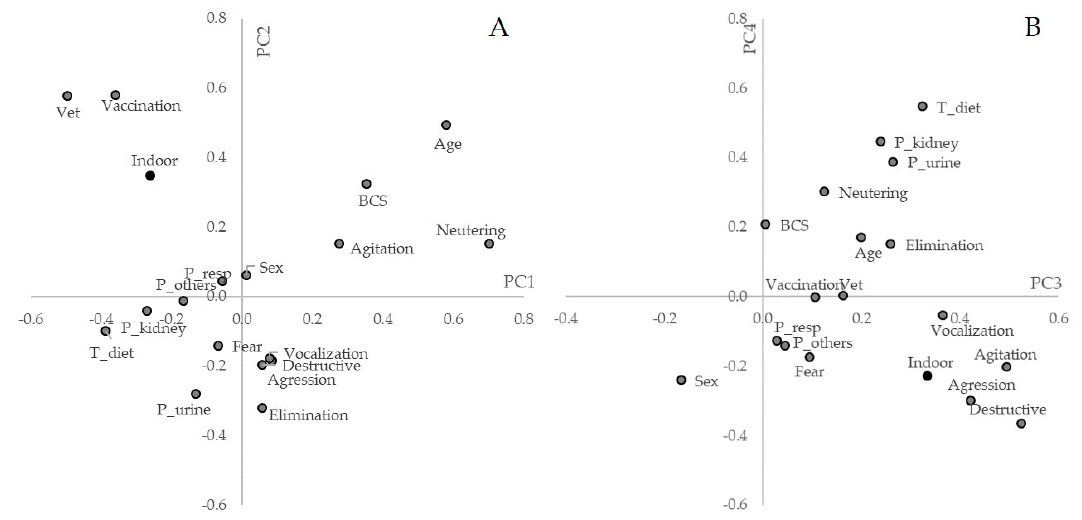
Figure 3. Plot of variables used in the Principal Component Analysis for the type of management, cats’ health, and behavioral problems. ( A ). Plot of principal components 1 and 2. ( B ). Plot of principal components 3 and 4. Acronyms refer to the following variables: ‘Vet visits’ (Vet), ‘Vaccination frequency (Vaccination), ‘Type of management’ (Indoor), ‘Respiratory problems’ (P_resp), Other health problems (P_others), ‘Kidney problems’ (P_kidney), ‘Urinary problems’ (P_urine), ‘Use of therapeutic feed’ (T_Diet), ‘Cat sex’ (Sex), ‘Cat body composition score’ (BCS), ‘Neutering’ (Neutering), ‘Cat’s age (Age), ‘Excessive vocalization’ (Vocalization), ‘Excessive agitation’ (Agitation), ‘Destructiveness behavior’ (Destructive), ‘Aggressiveness (Agression), ‘Excessive fear’ (Fear) and ‘Inadequate elimination of feces and urine’ (Elimination).